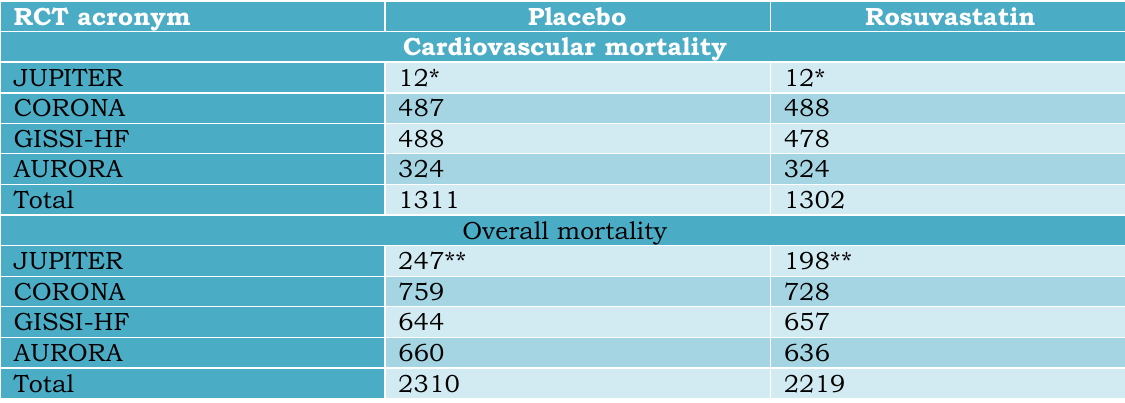
Table 2. Summary of mortality data in the 4 rosuvastatin RCTs RCT